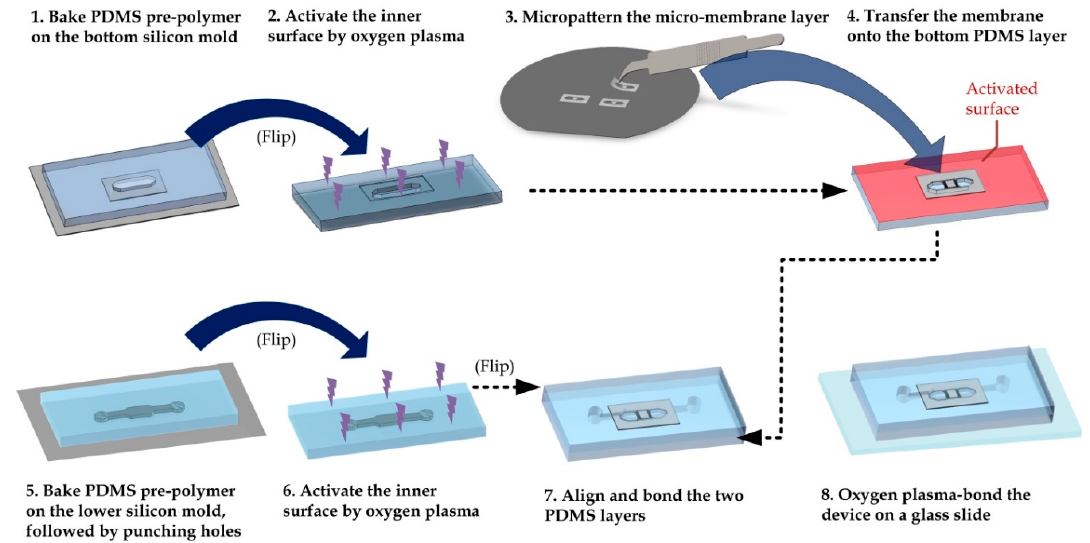
Figure A1. Fabrication process of the microfluidic viscometer.